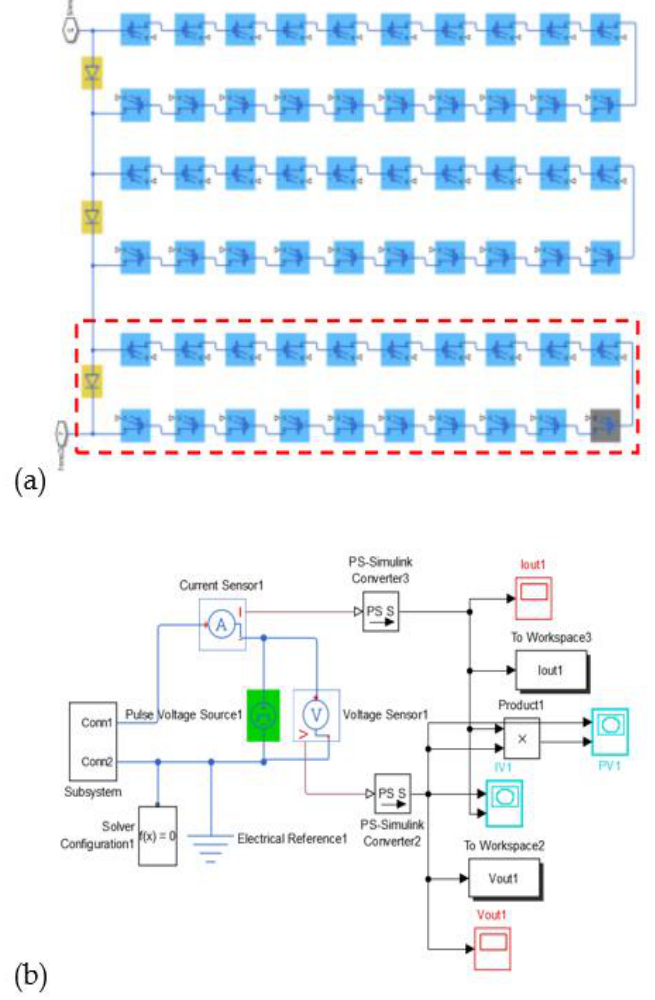
Figure 1. Diagram of the simulated PV module structure and simulation model. ( a ) Schematic diagram of the simulated PV module (the icon with the blue background is the solar cell with normal irradiance, the icon with the gray background represents the shadowed solar cell, the icon with the yellow background is the bypass diode, and the red rectangle shows a solar cell string). ( b ) Diagram of simulation model. Table 1. Electrical parameters of PV module used in simulation experiment.